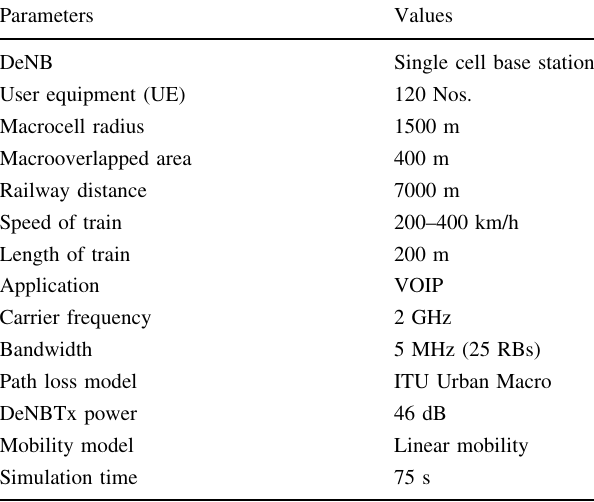
Table 2 Simulation parameters